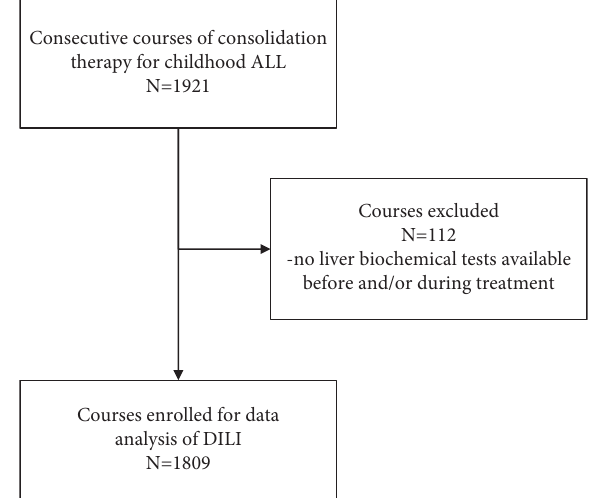
Figure 1: Flow chart of courses inclusion. ALL, acute lympho- blastic leukemia; DILI, drug-induced liver